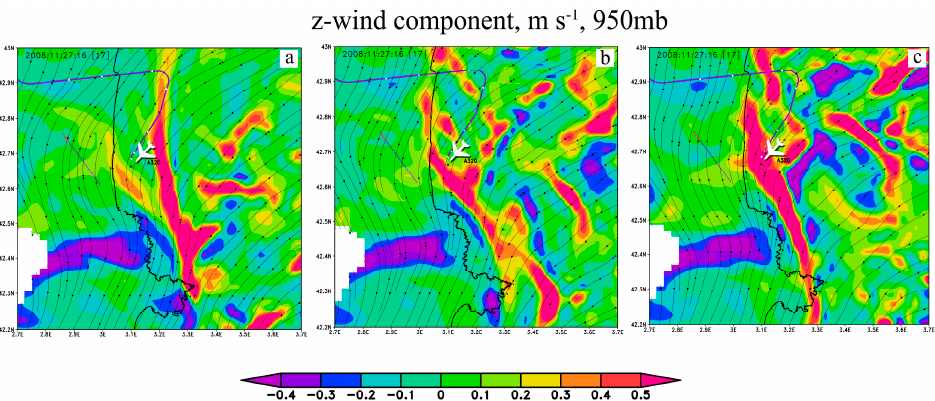
Figure 7. The A320-232 crash site, France, 2008. The z-wind speed for three types of local mixing conditions near the surface: in the absence of local mixing ( a ); the five-layer model of thermal diffusion ( b ); thermal diffusion with additional SST assimilation ( c ). The white area corresponds to the underground model level.